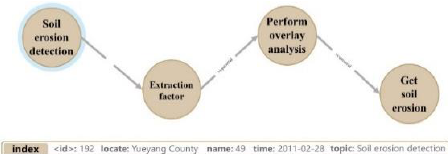
Figure 7 . Event chain